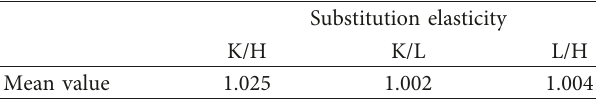
Table 6: Substitution elasticity of various elements.